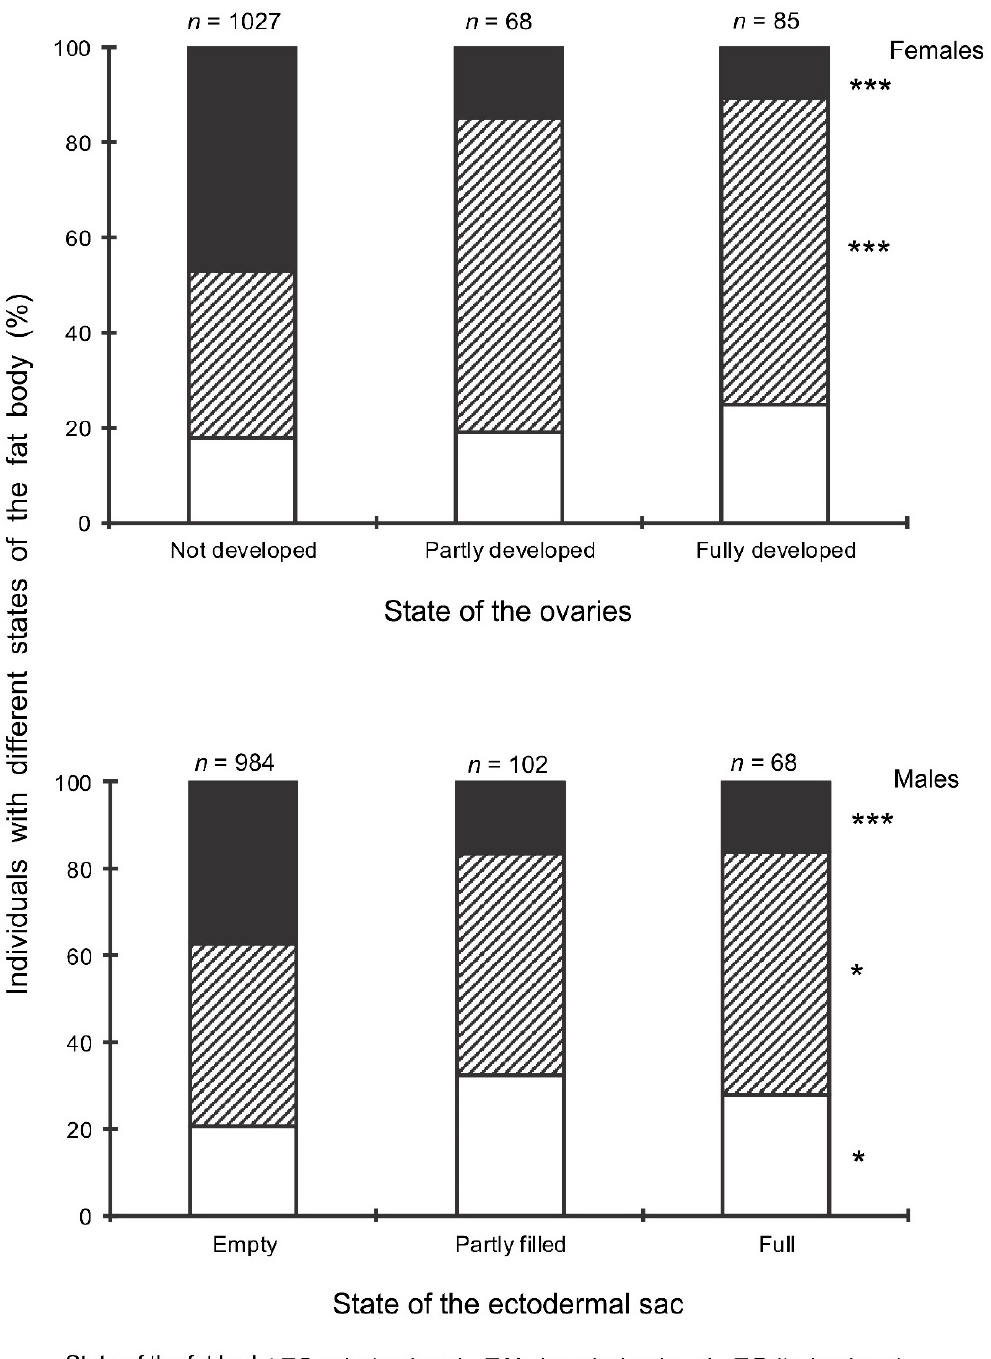
Figure 8. Correlation between the state of reproductive organs and the state of fat body in Halyomorpha halys females and males. Spearman’s correlation coefficients for the total data: females: ρ = − 0.194 ± 0.023 ( n = 1180); males: ρ = –0.149 ± 0.027 ( n = 1154). Sample sizes for the fractions with different states of reproductive organs are indicated above the bars. Asterisks to the right of the graph indicate significant difference in the proportions of individuals with the given state of fat body between males with different states of the ectodermal sack as well as between females with different states of the ovaries (sections with the same fill pattern of different bars of the same graph): *— p < 0.05, ***— p < 0.001 by the Chi-square test.